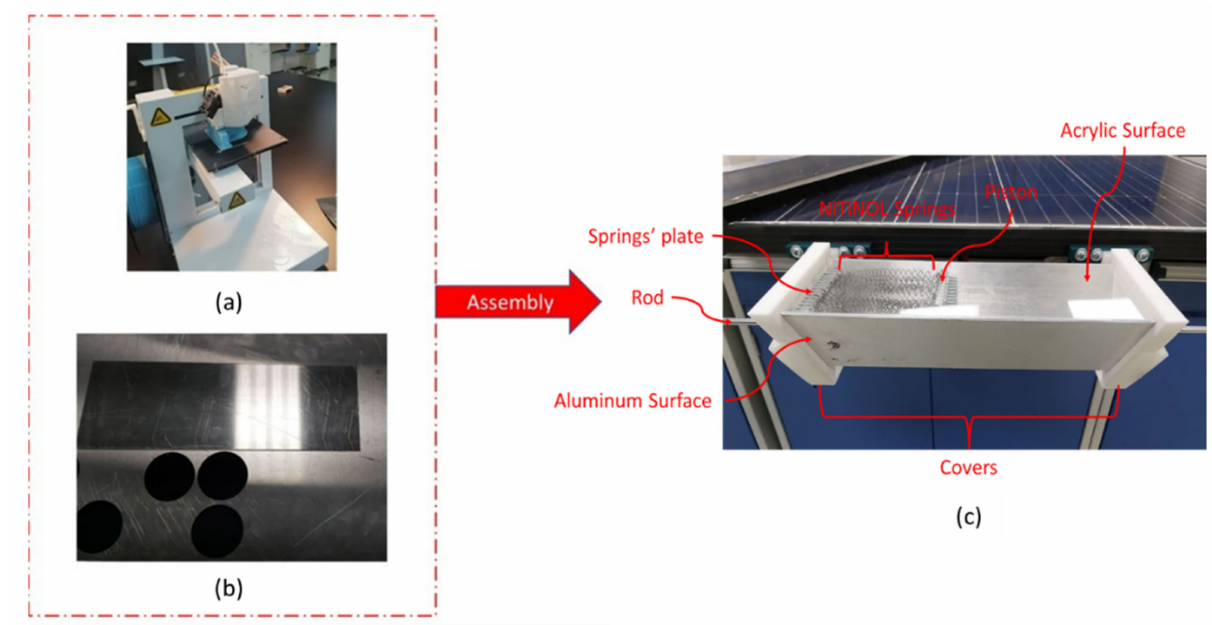
Figure 6. Implemented rapid prototyping techniques with ( a ) 3D printer, ( b ) laser cutting machine, and ( c ) fully assembled actuator.